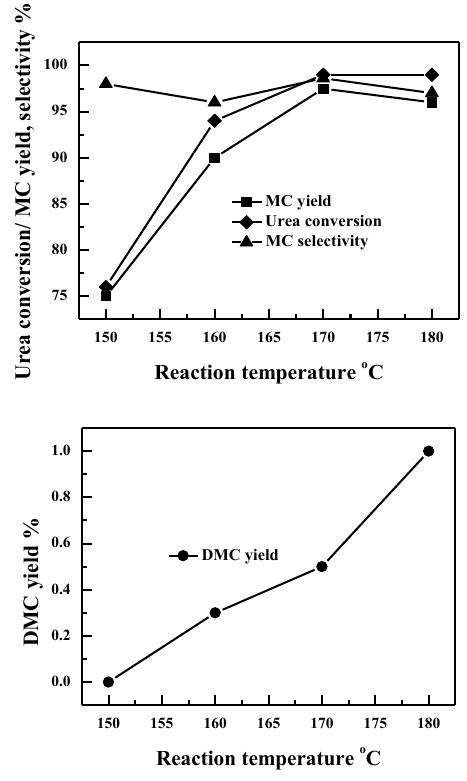
Figure 10. Effect of reaction temperature on urea conversion; yields of 1 and 2 , and selectivity for 1 . Urea 1 g, methanol 13.5 mL, 0.1 g 2.9 wt% TiO 2 /SiO 2 -500, reaction time: 6